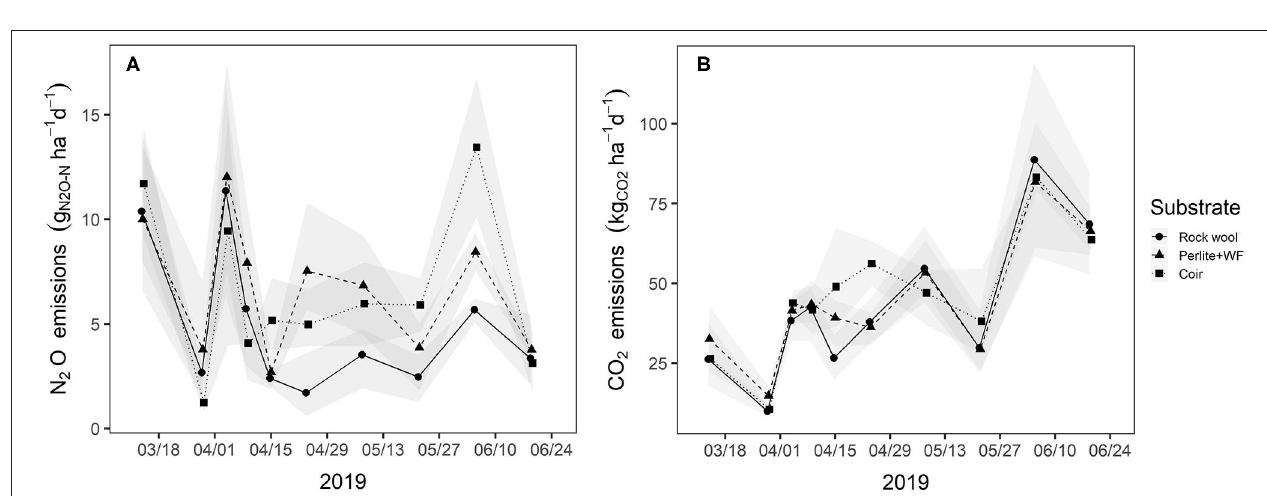
FIGURE 4 | N 2 O (A) and CO 2 (B) emission rates from the root zone of tomatoes grown in perlite/wood fiber growing bags (Perlite + WF, triangles and dashed lines) and coir growing bags (squares and dotted lines) compared to rock wool growing bags (circles and solid lines) in spring 2019. Symbols show mean values of n = 4 replicates ( n = 2 for the first four points of Coir, and for the last point of Coir and Perlite + WF) and shaded areas the corresponding 95% confidence intervals.